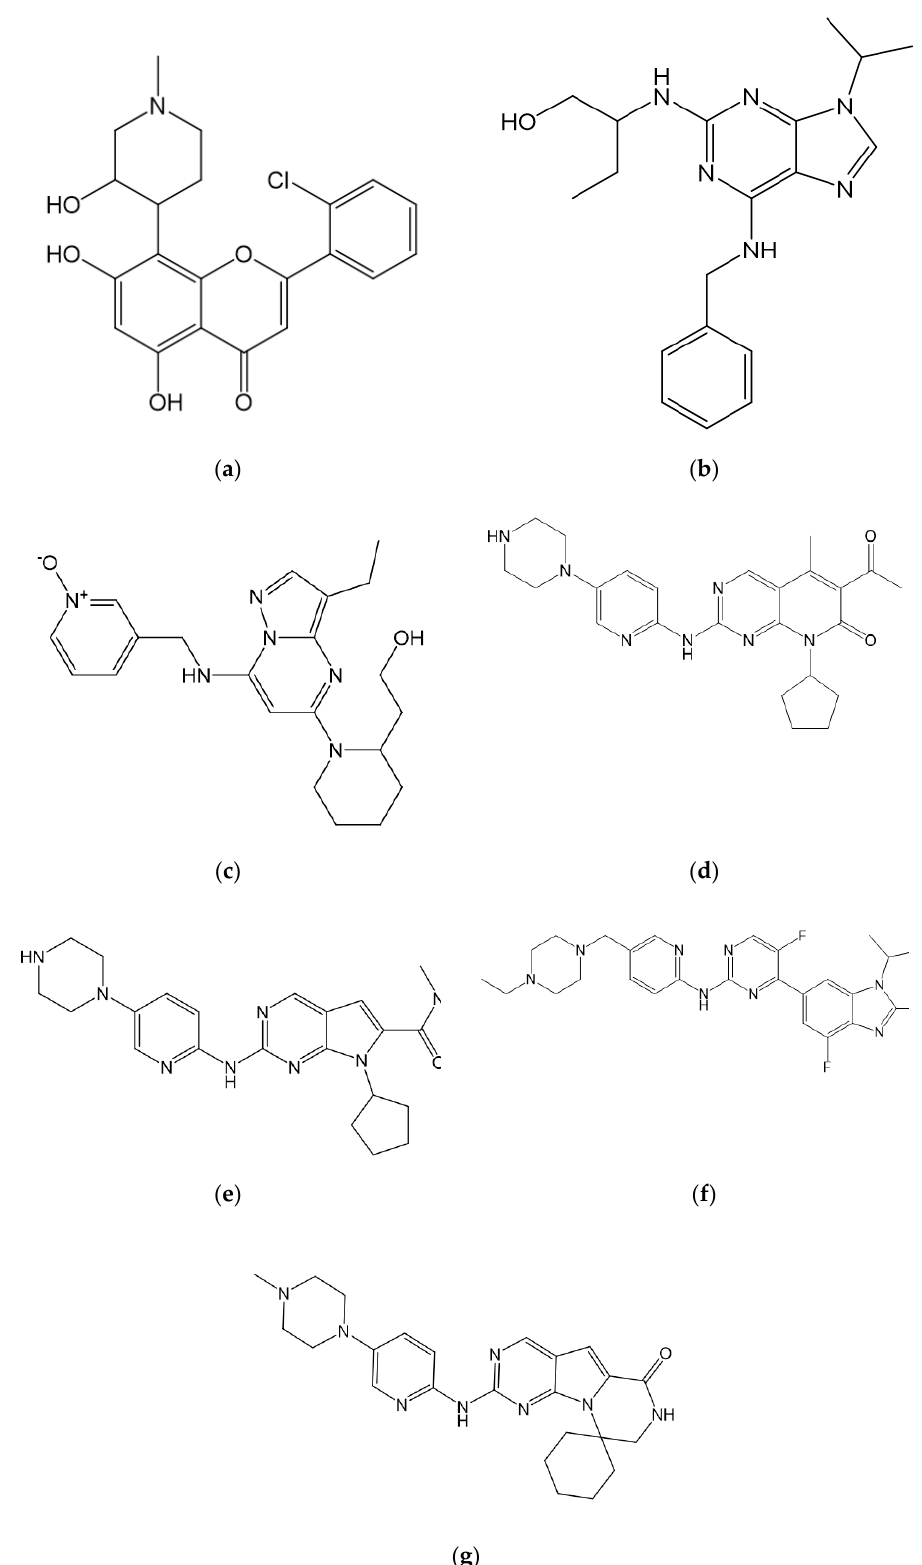
Figure 4. Chemical structure of CDK inhibitors: ( a ) Flavopiridol/Alvocidib, ( b ) seliciclib/roscovitine, ( c ) dinaciclib, ( d ) palbociclib, ( e ) ribociclib, ( f ) abemaciclib, and ( g )